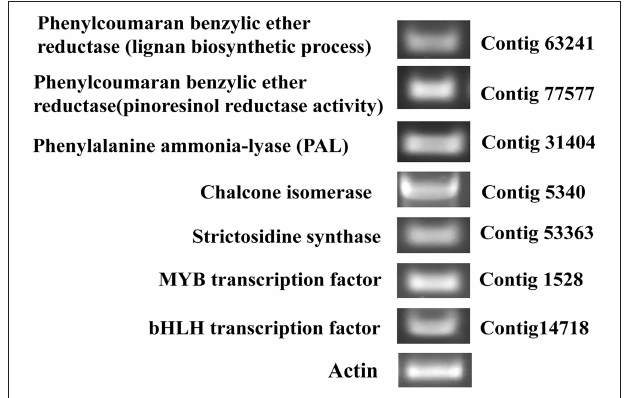
FIGURE 12 | RT-PCR image of selected P. amarus unitranscripts expressed in leaf samples of P. amarus